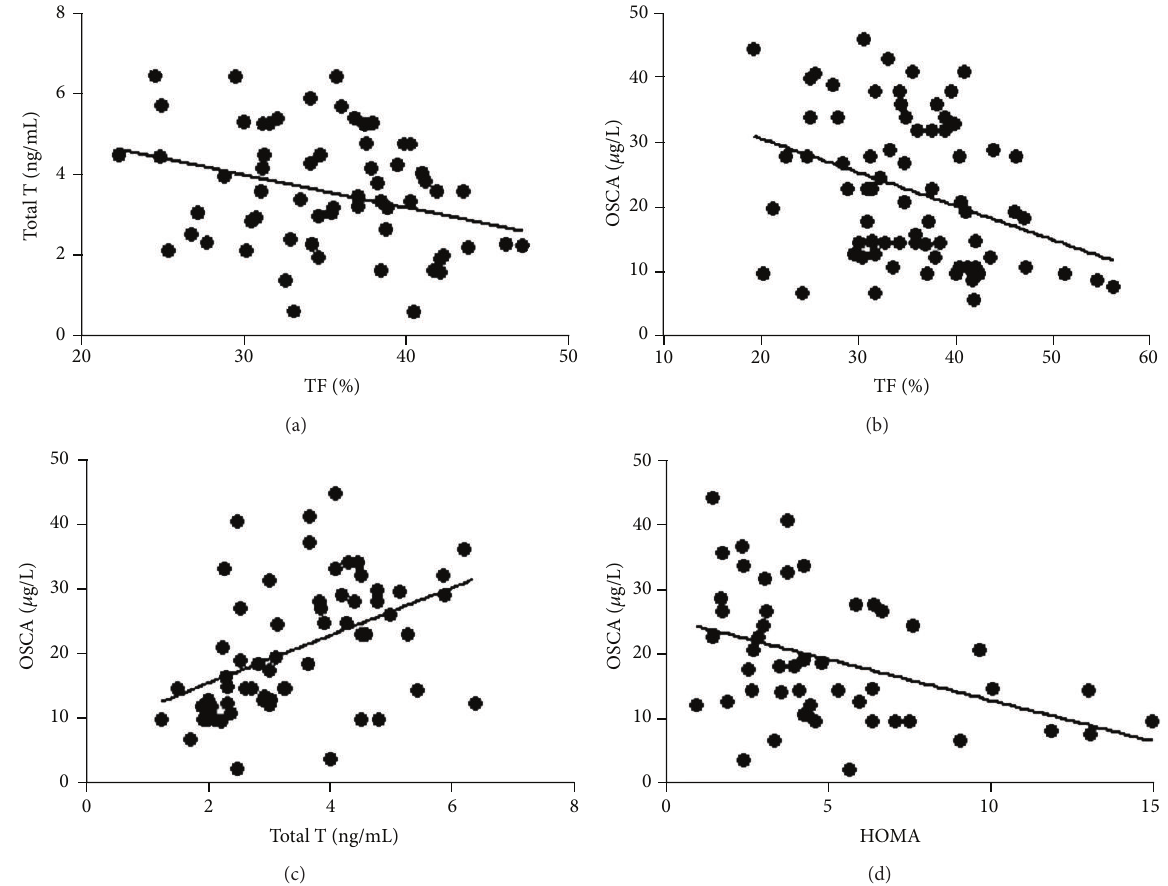
Figure 1: Correlation between (a) total testosterone (total T) and trunk fat (TF) ( 𝑃 < 0.01 , 𝑟 2 = −0.26 ), (b) osteocalcin (OSCA) and TF ( 𝑃 < 0.001 , 𝑟 2 = −0.17 ), (c) OSCA and Total T ( 𝑃 < 0.0001 , 𝑟 2 = 0.23 ), (d) OSCA and HOMA ( 𝑃 < 0.001 , 𝑟 2 = −0.20 ). 𝑟 2 = −0.24 , Figure 2(c), respectively) was found; regression